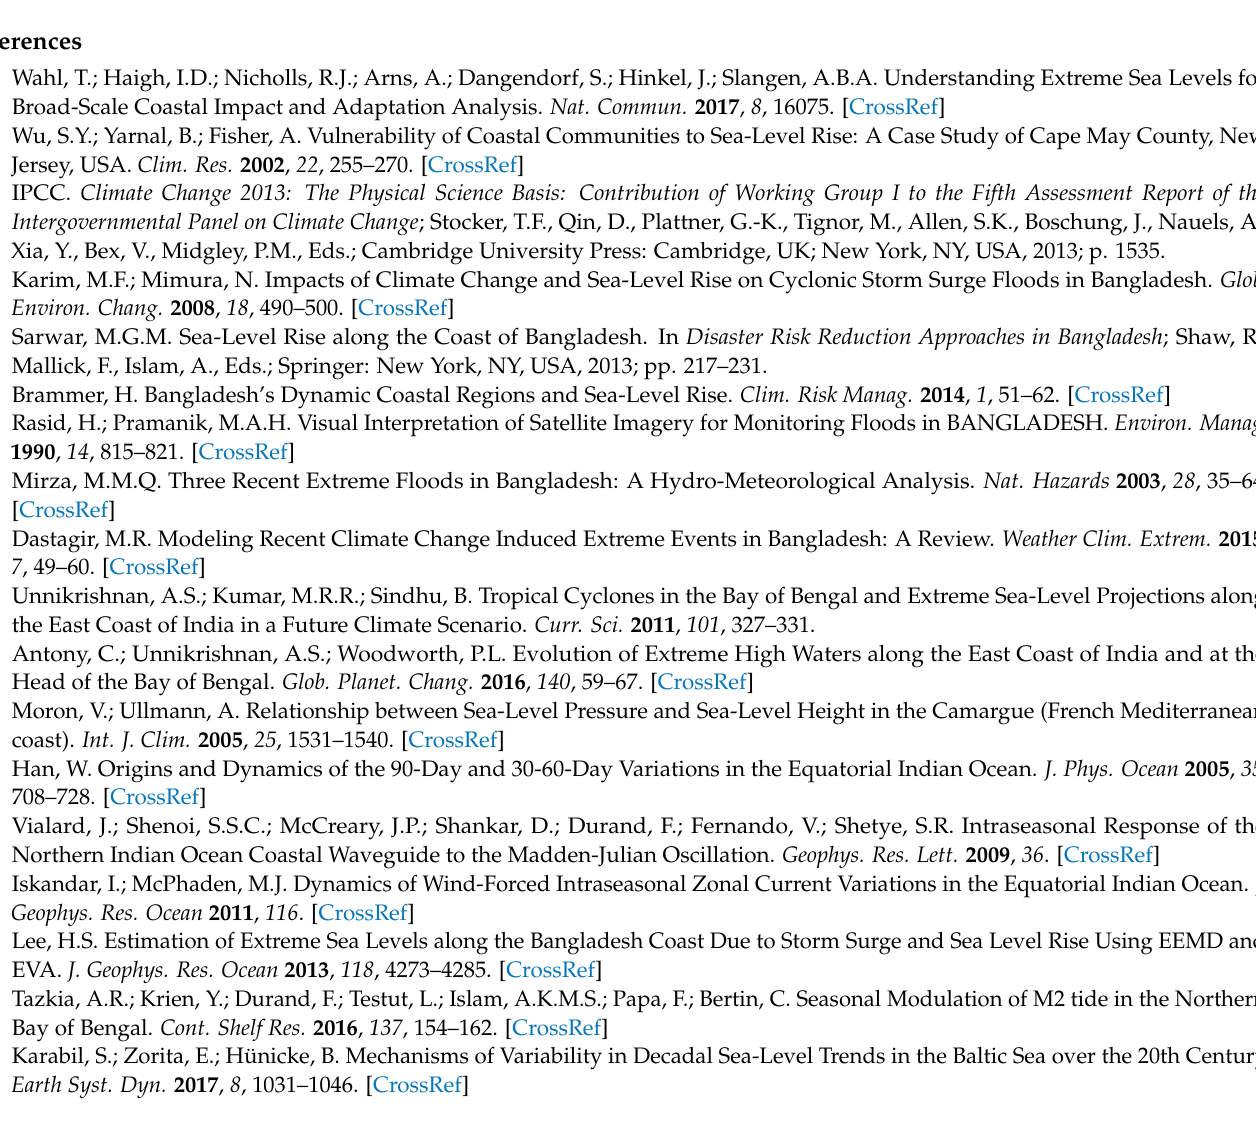
Figure A2. The relationship between the R 2 values of sea level predictions at Cox’s Bazar, based on MLR for WP and WOP, using different accumulation days for precipitation. In ( a ), 3 days of accumulated precipitation was used. ( b , c ) same as ( a ) but for 5 days and 7 days, respectively. Each dot corresponds to an ESL event. Red and black dots represent the R 2 for predictions WP and WOP, respectively. The y-axis represents the R 2 for predictions WP. The x-axis represents the differences in R 2 between WP and WOP predictions.